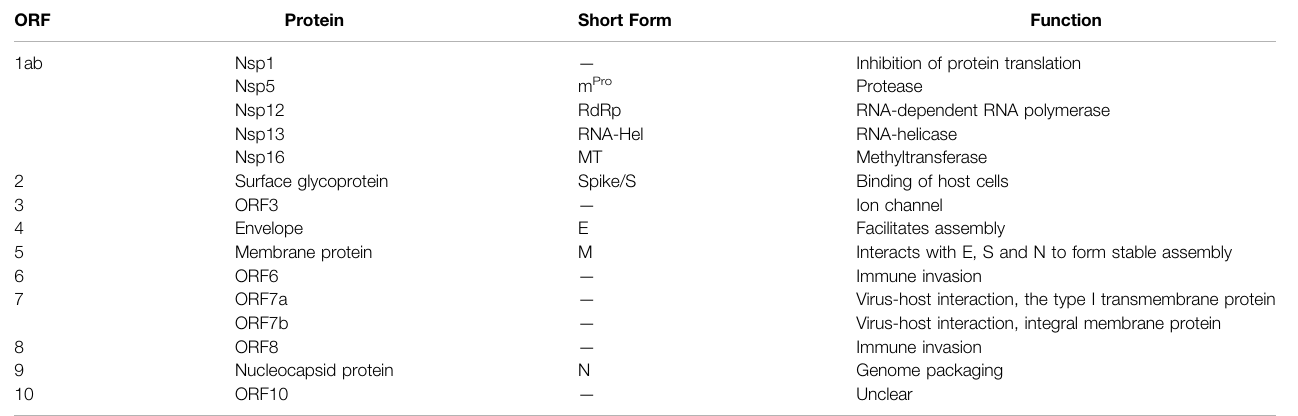
TABLE 1 | SARS-CoV-2 viral proteins and their characteristics.